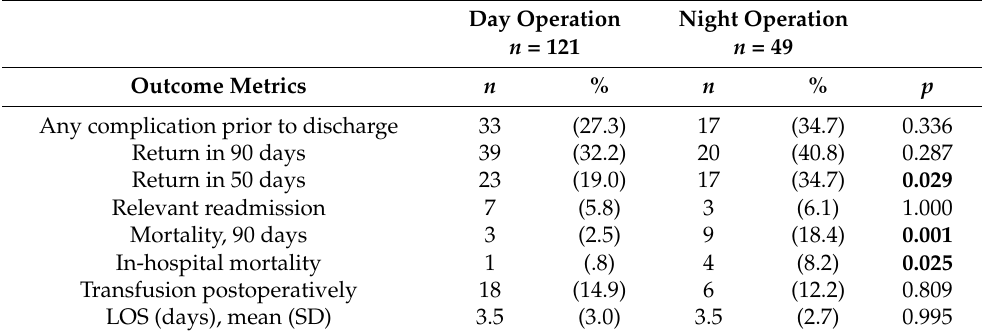
Table 4. Comparison of Various Outcome Metrics for Day and Night Operations ( n =